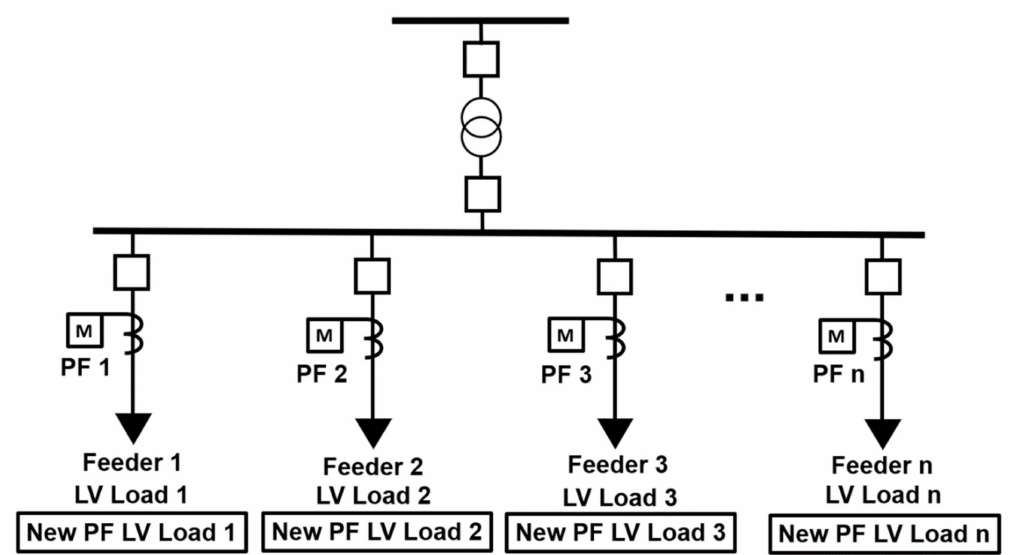
Figure 4. Illustration of applying methodology for power factor adjustment to all substation’s feeders.